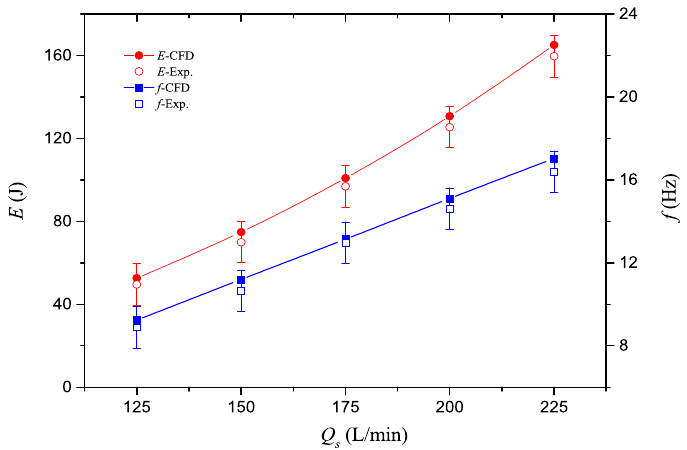
Figure 12. Comparison of the results (single ‐ impact energy and impact frequency) obtained by computational fluid dynamics (CFD) simulation and experimental tests (the difference is smaller than 7%).